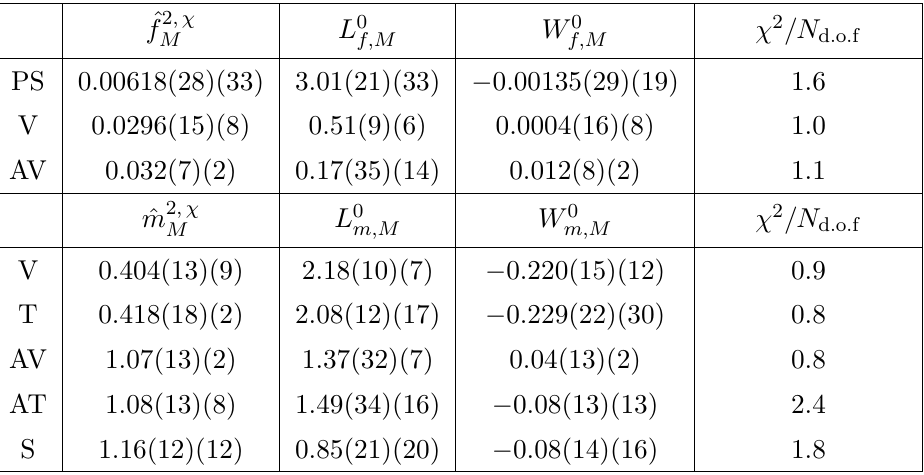
Table 8. Fit results of the continuum and massless extrapolations for masses squared and decay constants squared of mesons in the dynamical simulations. The low-energy constants appearing in W (cid:31) PT are de(cid:12)ned in eqs. (4.13) and (4.14). The (cid:12)ts of ^ f 2 measurements are restricted to include PS only the eleven ensembles identi(cid:12)ed in the main text. For the other quantities, additional ensembles . 0 : 6 and ^ a . 1 have been included. In parenthesis, we report the statistical and satisfying ^ m 2 PS systematic uncertainties,